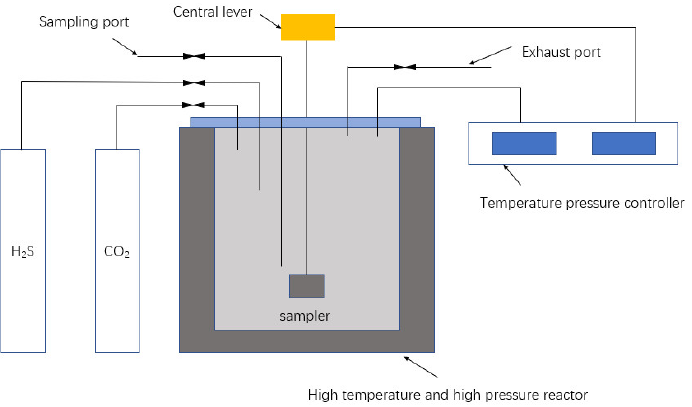
Figure 1. High temperature and high-pressure water–rock reaction device. Table 2. Microscopic ion reaction process of water–rock reaction in carbonate sour gas